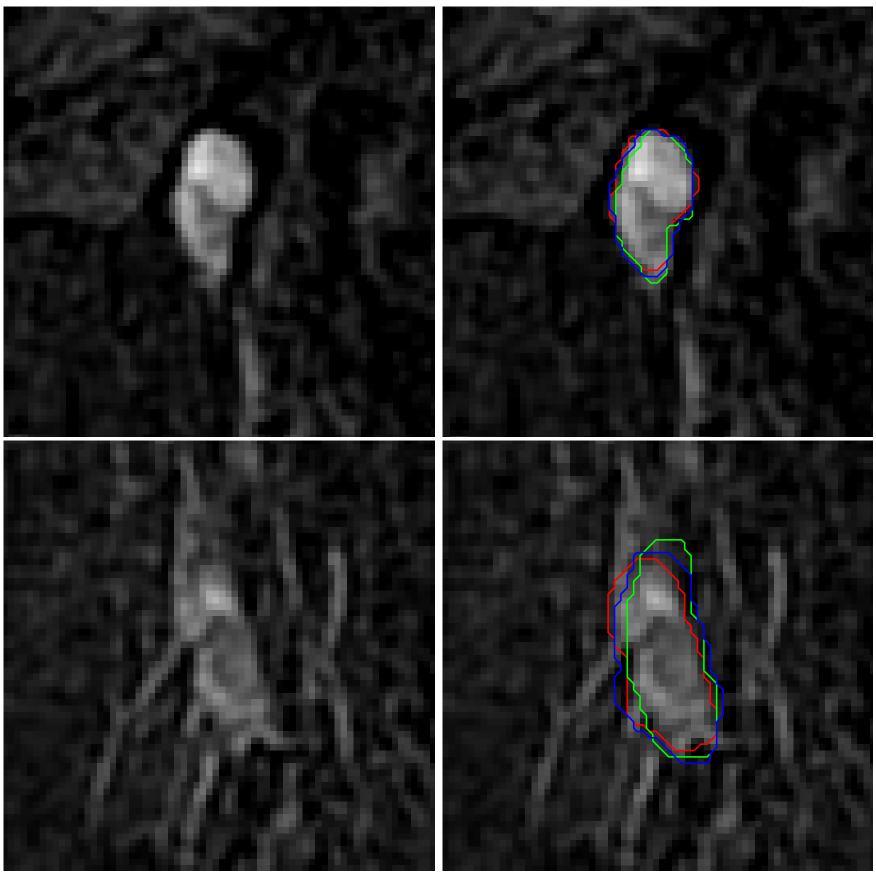
Figure 1. Examples related to a benign (on the top) and a malignant (on the bottom) breast mass. For each example, the DCE-MRI image area is shown without (on the left) and with (on the right) delineation contours. Segmentation results yielded by the automated delineation (red contour) and manual delineations—performed by the first (green contour) and the second (blue contour) radiologist—are compared. All figures are shown with a 2.5 × magnification